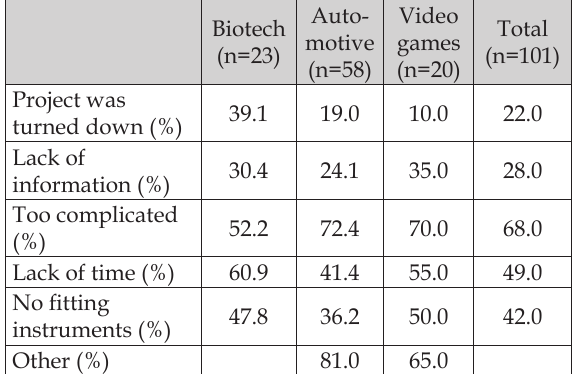
Fig. 1. Positioning of regional industries within the knowl- edge base concept triangle. Source: Plum (2011: 181); inspired by Asheim (2007: